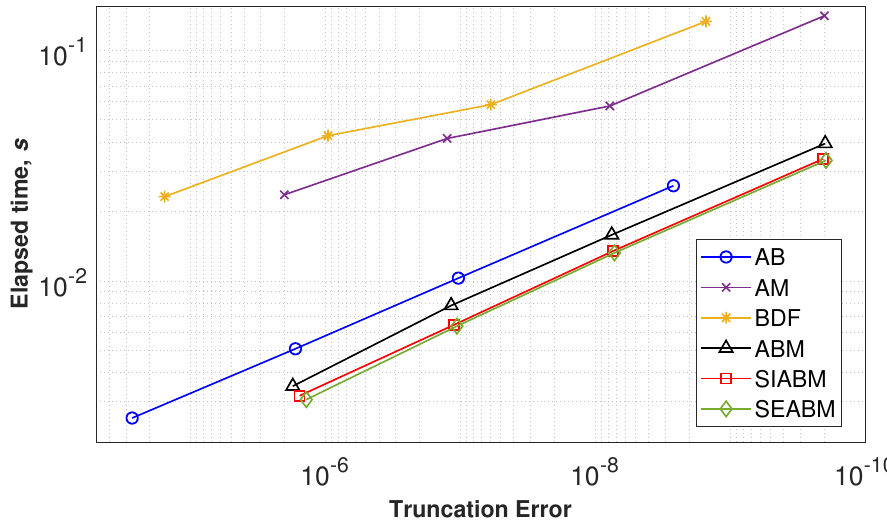
Figure 3. Performance plots for investigated multistep ODE solvers simulating system (7) with fixed step.